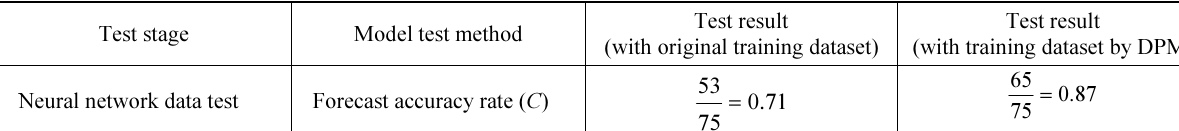
Table 6. Test results of the test